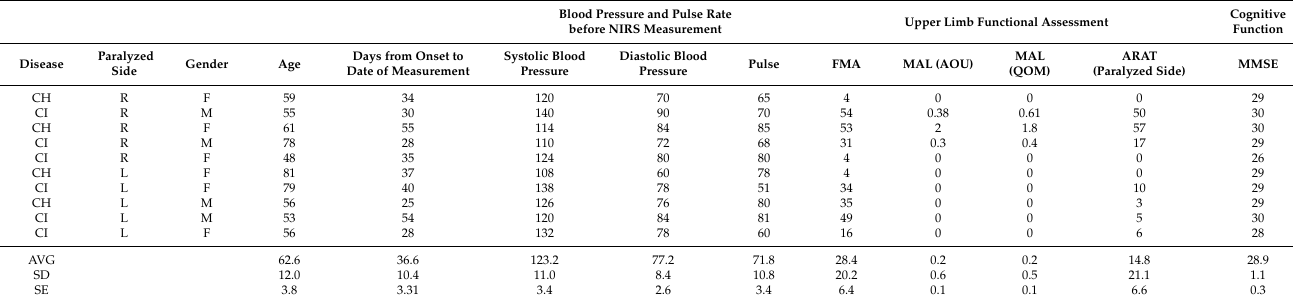
Table 1. Characteristics of the study participants. BloodPressureandPulseRate